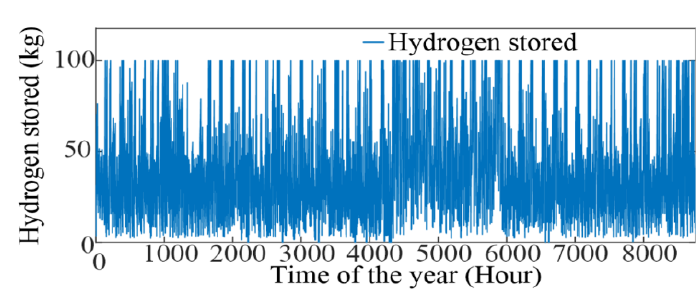
Figure 11. Hydrogen production over the year: combination 2.